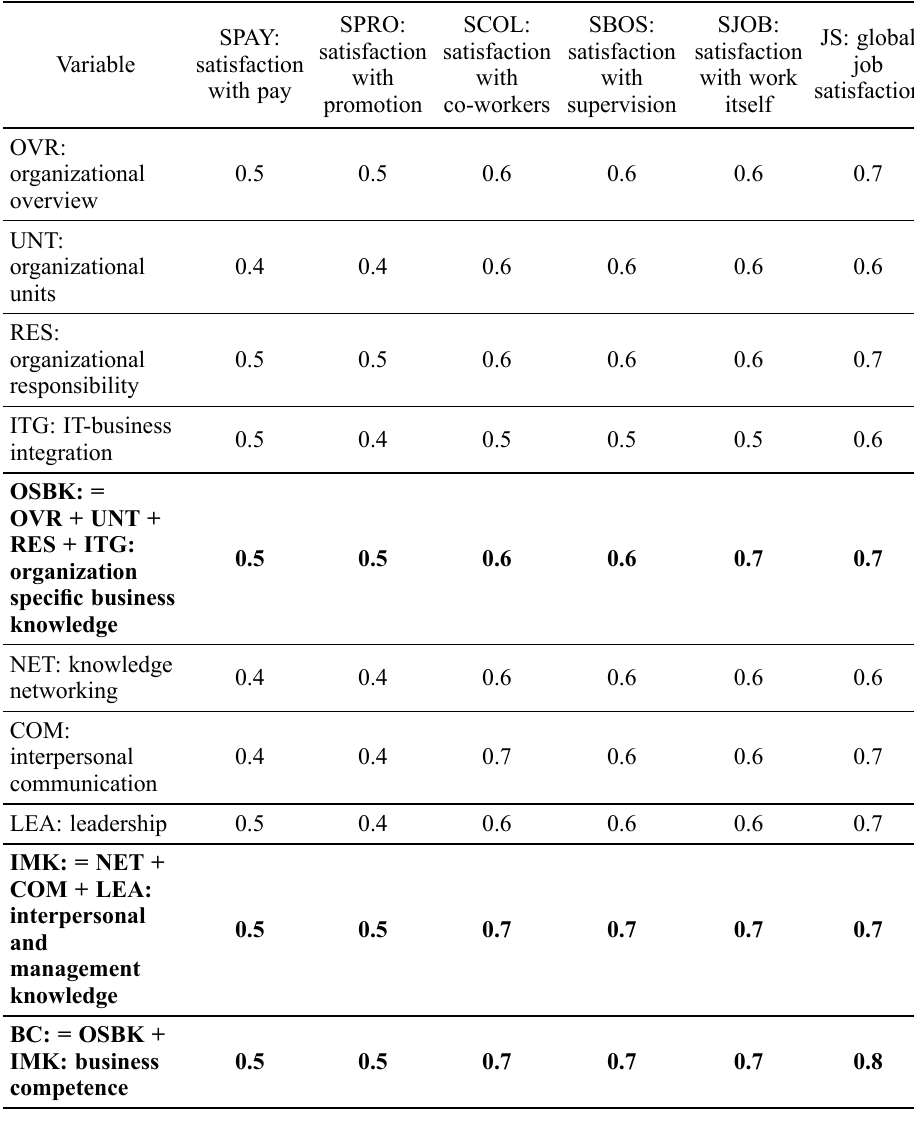
Table 7. Pearson’s linear correlation coefficient